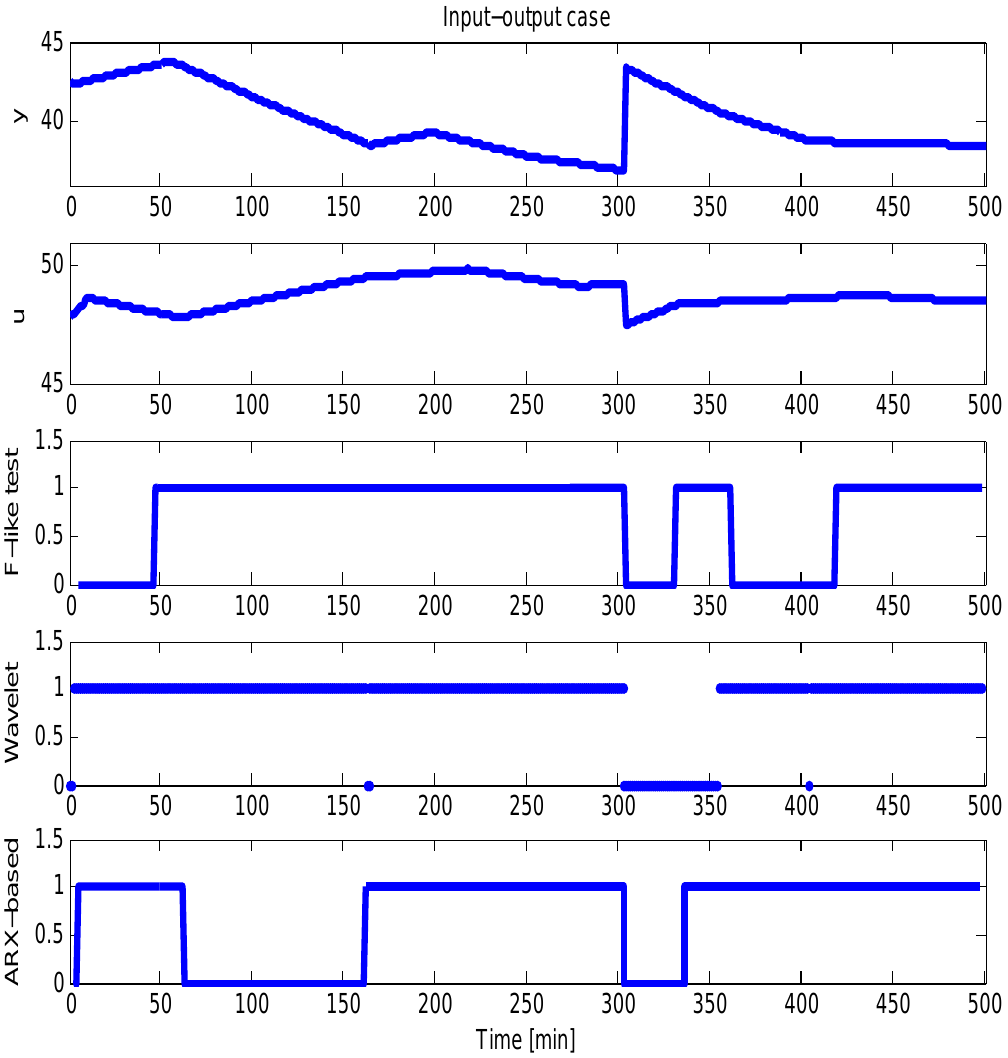
Figure 17. HX4 input-output case with a measurement frequency of 1